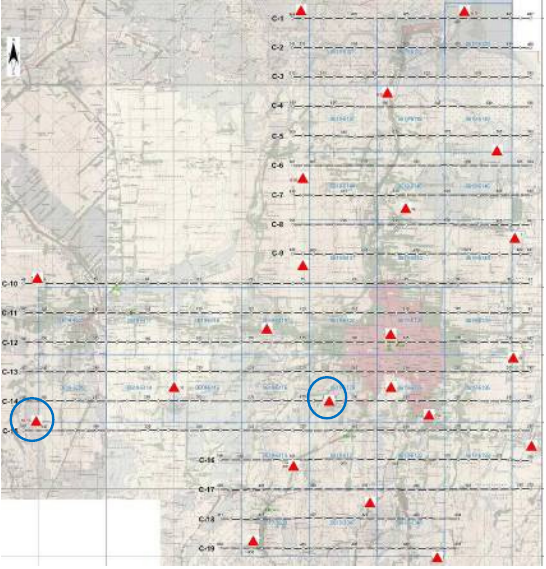
Figure 4. GCP and flight plan